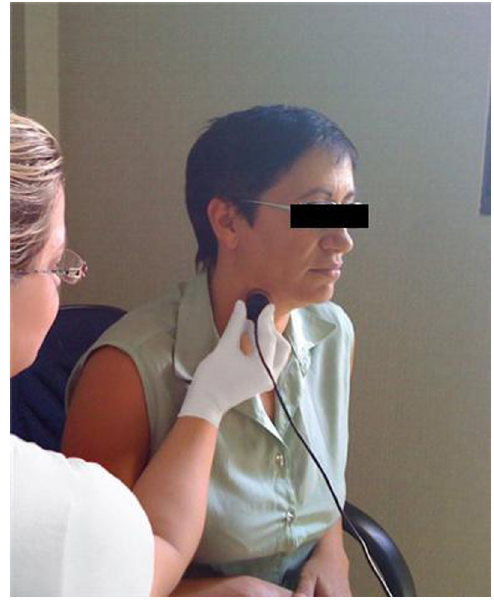
Figure 2 Transducer placement position in the patient. Figure 3 Ultrasonic detector (portable), DF-4001,